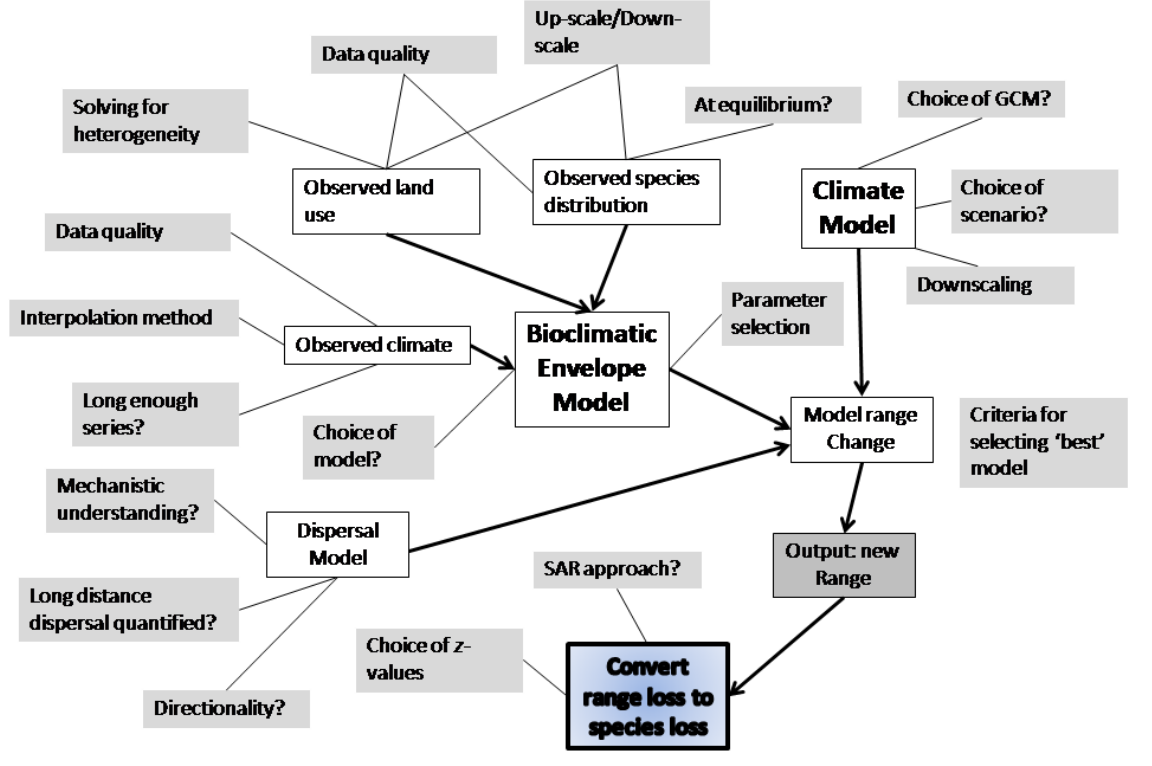
Figure 1. Some of the steps, choices and assumptions involved in modelling species losses resulting from future climate change using the species distribution modelling approach. Not all studies involve all elements, e.g., land-use data, or dispersal models, but these components are important for increased realism (re-drawn from